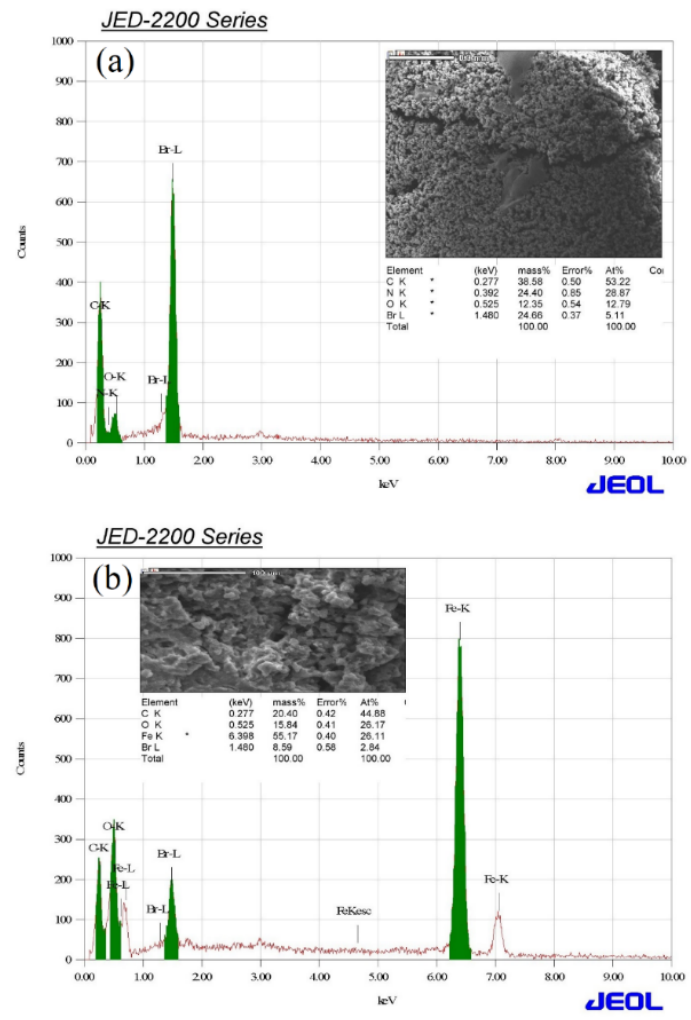
Figure 7. EDX results for ( a ) CQVP/MA and ( b ) CQVP/MA-Fe 3 O 4 .